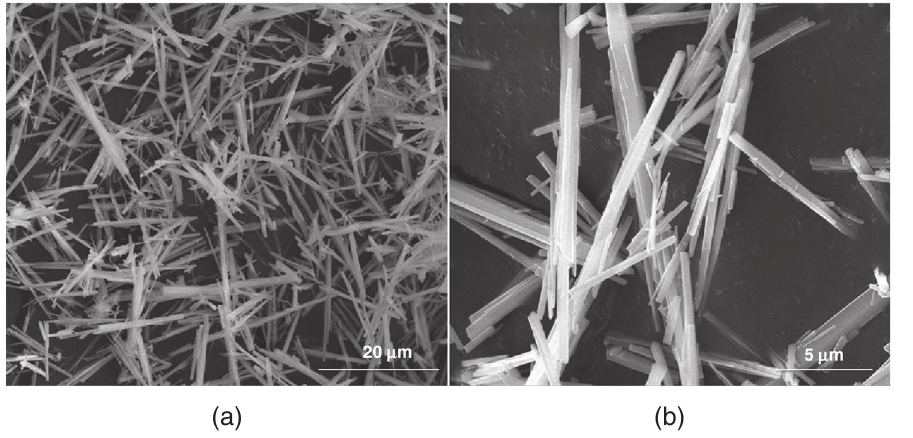
Figure 8: SEM photos of BaCO 3 particles prepared under optimal experimental conditions by microwave homogeneous precipitation. (a) 4,000 (cid:2) ; (b) 13,000 (cid:2)